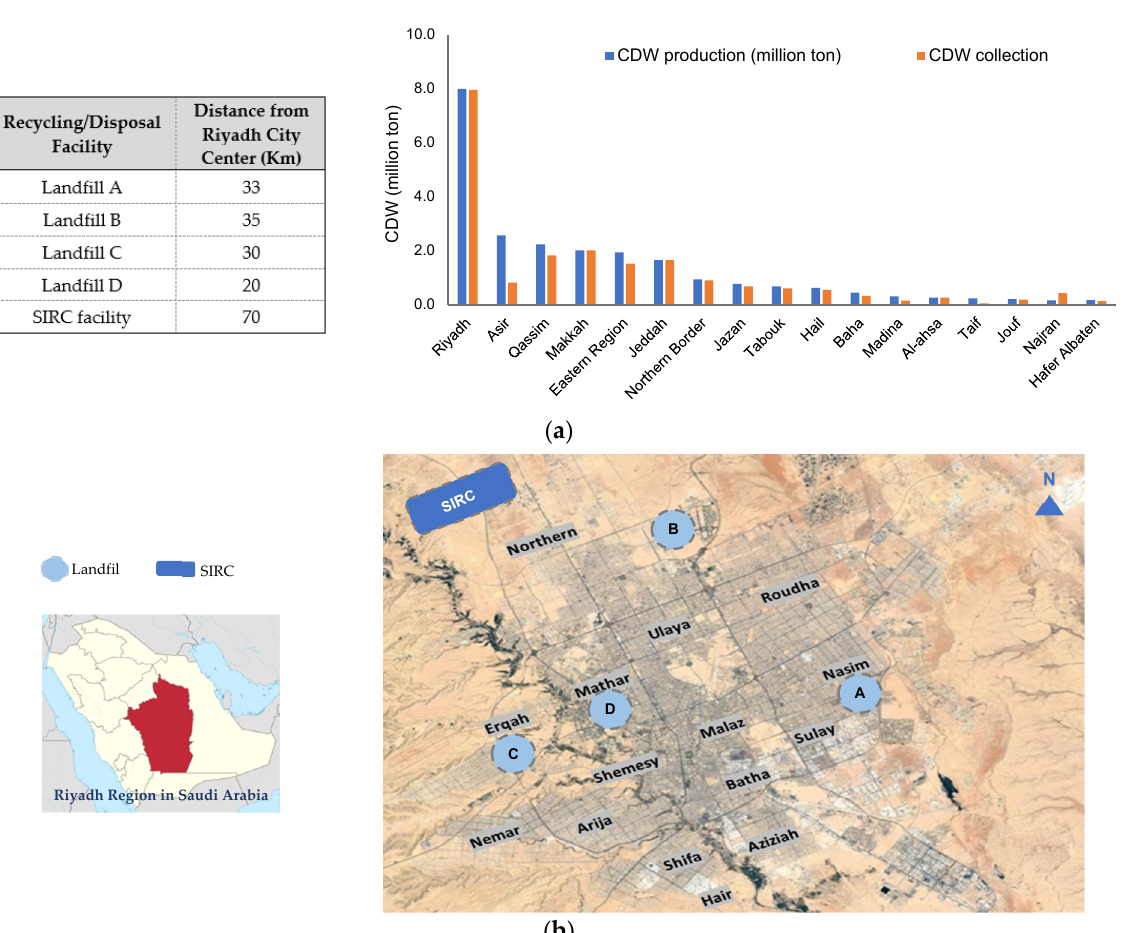
Figure 1. CDW management scenario in Saudi Arabia, ( a ) CDW collection in different regions, ( b ) study area defining the boundaries of Riyadh City and its 15 districts (Letters A–D represents locations of landfills) [16,19].